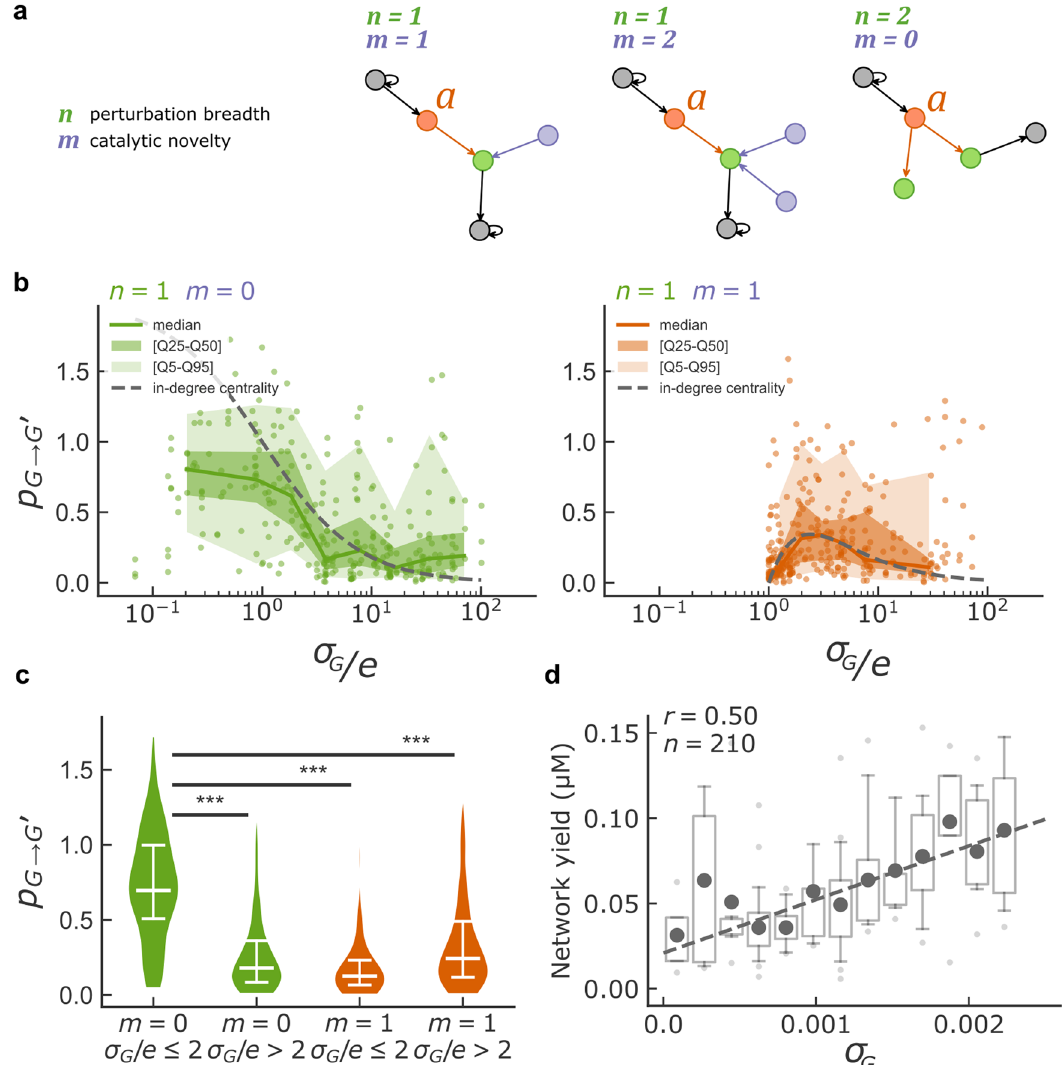
Fig. 3 Network perturbation analysis. a Schematic of three situations where the parameters n , the number of targets of added catalyst a , and m , the number of catalysts sharing the same IGS as a , have different values. b The perturbation p G ! G 0 is plotted against σ G / e for different values of the parameters m and n for the networks with 3 and 4 species before addition of the new catalyst a . Dots are the measurement for one perturbation, the colored line is the median, shadings indicate 25 – 75 and 5 – 95 percentiles, and the dotted grey line is the in-degree centrality prediction. To compute percentile statistics, data points were binned in 10 bins along the x-axis and bins with fewer than 10 points were discarded. c Violin plot (with the median and interquartile range in white) of p G ! G 0 with catalytic innovations ( m = 0, green, n = 101 and 202 perturbations) or without catalytic innovations ( m = 1, orange, n = 130 and 166 perturbations) at high and low values of σ G / e . Two-sided Mann – Whitney U test p-values are reported (*** p -value < 0.001, p = [8e-21, 2e-22, 2e-15] from left to right, H0: equal means). d Network yield ( µ M, see Methods, n = 210 networks) is plotted against σ G for network with four species. Dark gray dots are mean values, quartile boxplots have 5 – 95th percentiles whiskers with fl ier points. The dotted gray line is the identity line. Pearson correlation coef fi cient is reported ( p -value <